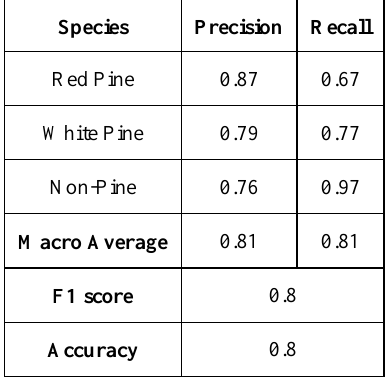
Table 4. Performance measures for Species Classification using